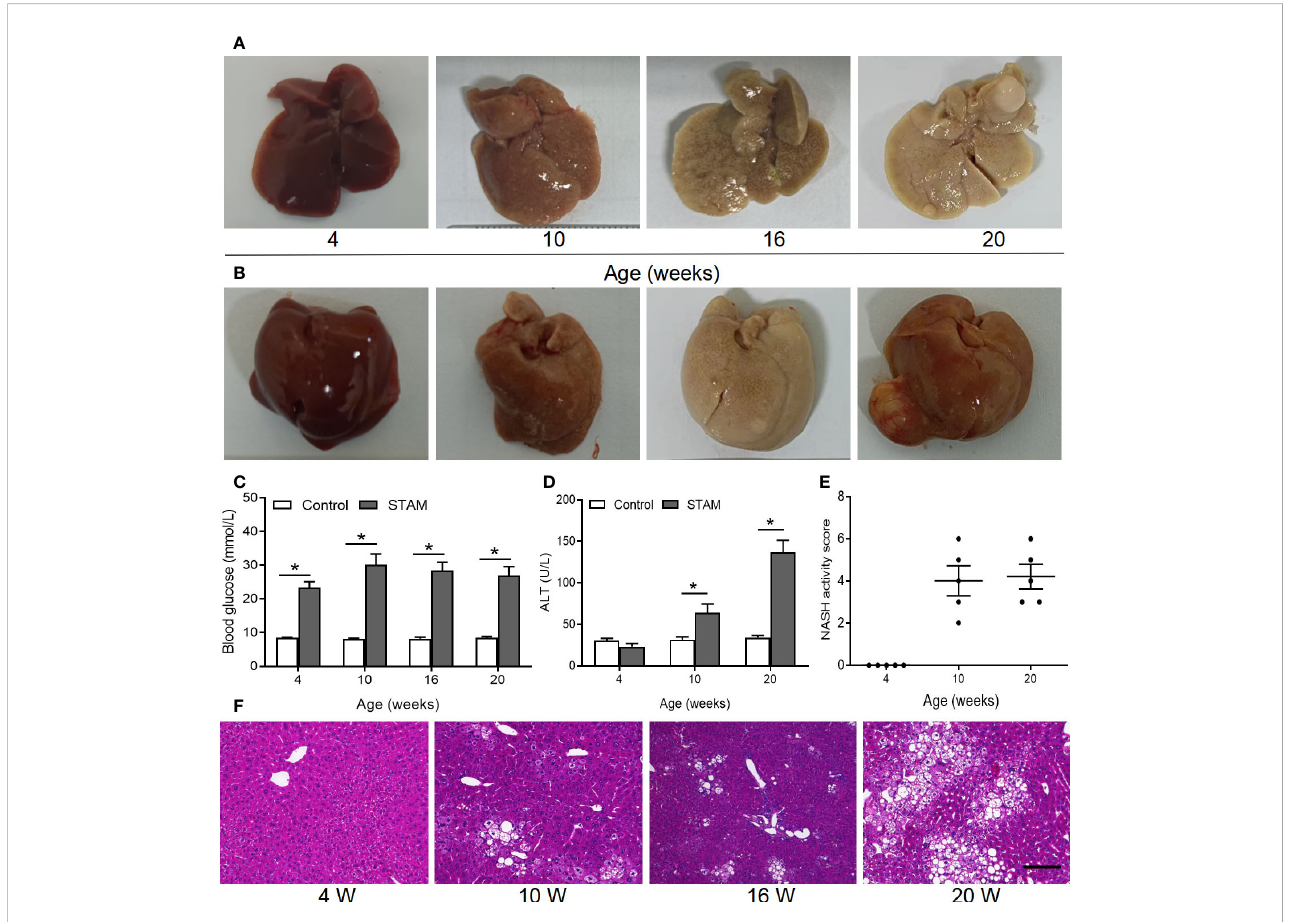
FIGURE 2 The STAM model of diabetes and high fat diet leading to NASH and HCC. (A, B) By 20 weeks, male mice develop numerous liver tumors (n=6). Macroscopic image of the (A) back and (B) front side of liver surface. The serum levels of blood glucose (C) and ALT which were detected by ELISA (D) of the STAM mice were elevated. (E) STAM mice progressed with increased NASH activity scores (NAS) from 10 weeks of age. (F) Paraf fi n-embedded and frozen mouse liver sections were stained with haematoxylin and eosin (H&E) to determine liver histology (Scale bars, 50 µm). ALT, alanine aminotransferase. *P<0.05 vs STAM group by unpaired Student ’ s t